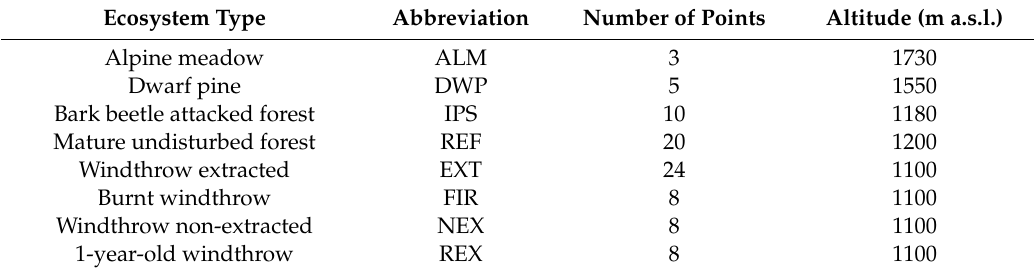
Table 2. Numbers of sampling points for estimation of soil respiration in di ff erent ecosystems. Ecosystem Type Abbreviation Number of Points Altitude (m a.s.l.) Alpine meadow ALM 3 1730 Dwarf pine DWP